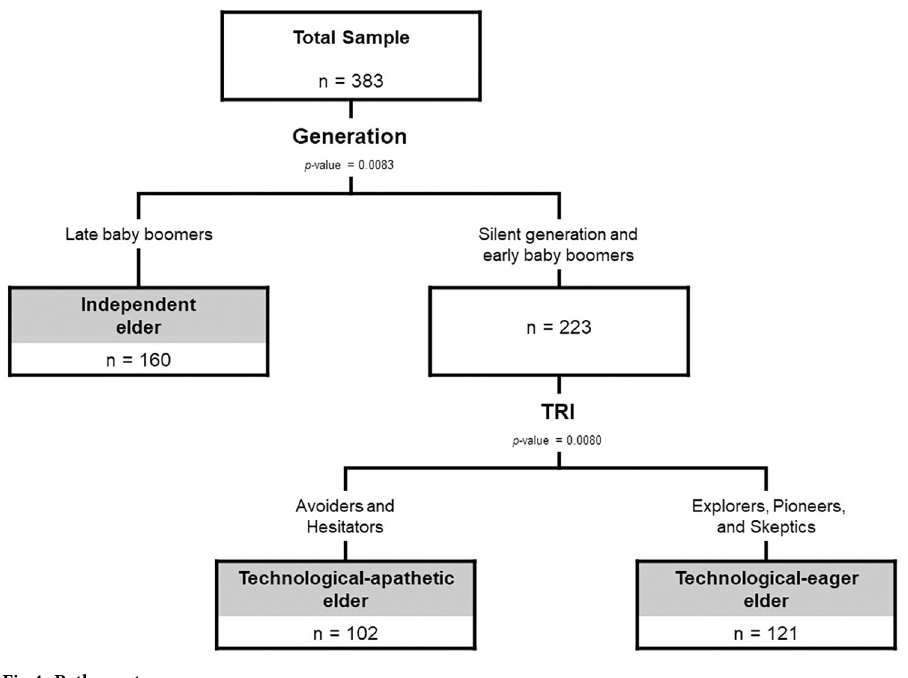
Fig 4. Pathmox tree.